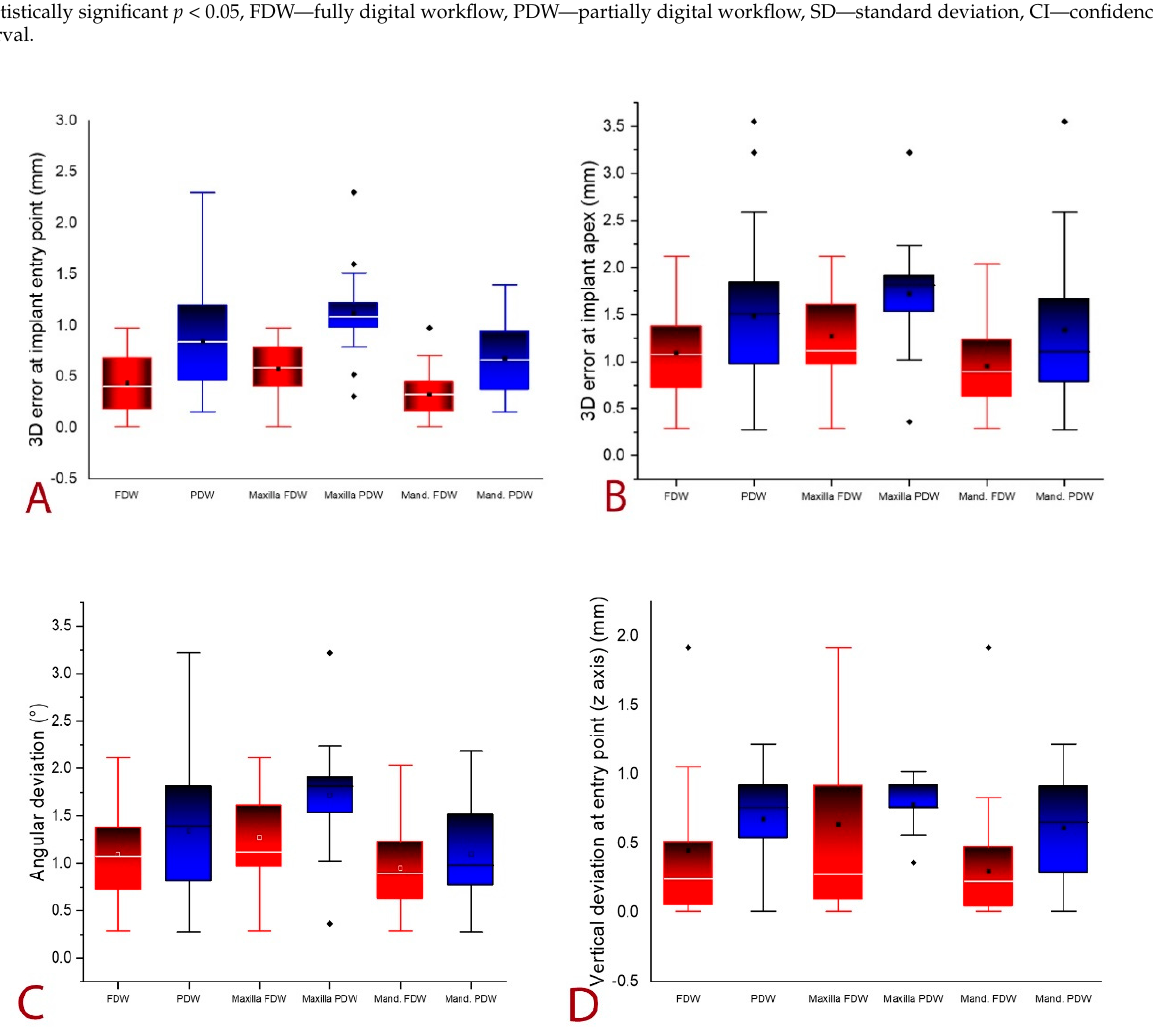
Figure 9. Assessment of response to the VAS questionnaire (0 meaning not satisfied at all and 10 Figure 8. ( A ) 3D error at implant entry point overall and separately evaluated for maxilla and mandible; ( B ) 3D error at implant apex overall and separately evaluated for maxilla and mandible. ( C ) Angular deviation; ( D ) Vertical deviation at entry point. The boxplots symbols significance: box—interquartile range (IQR), range within IQR, — median line, (cid:3) mean, ♦ outliners. Red plots are for FDW group and blue plots are for PDW